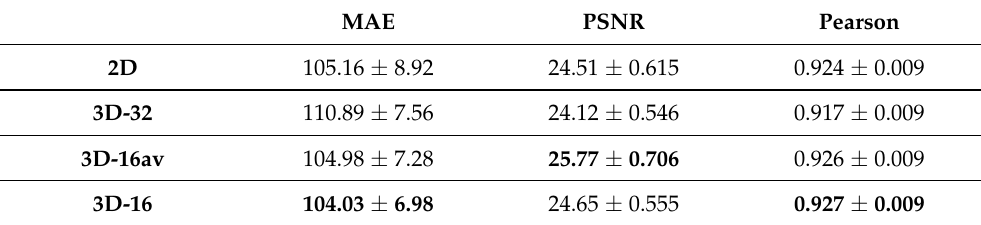
Table 2. Head dataset with Atrous-Net. Mean Absolute Error, PSNR and Pearson coefficient on the head data set obtained using Atrous network with different convolutions and reconstructions.